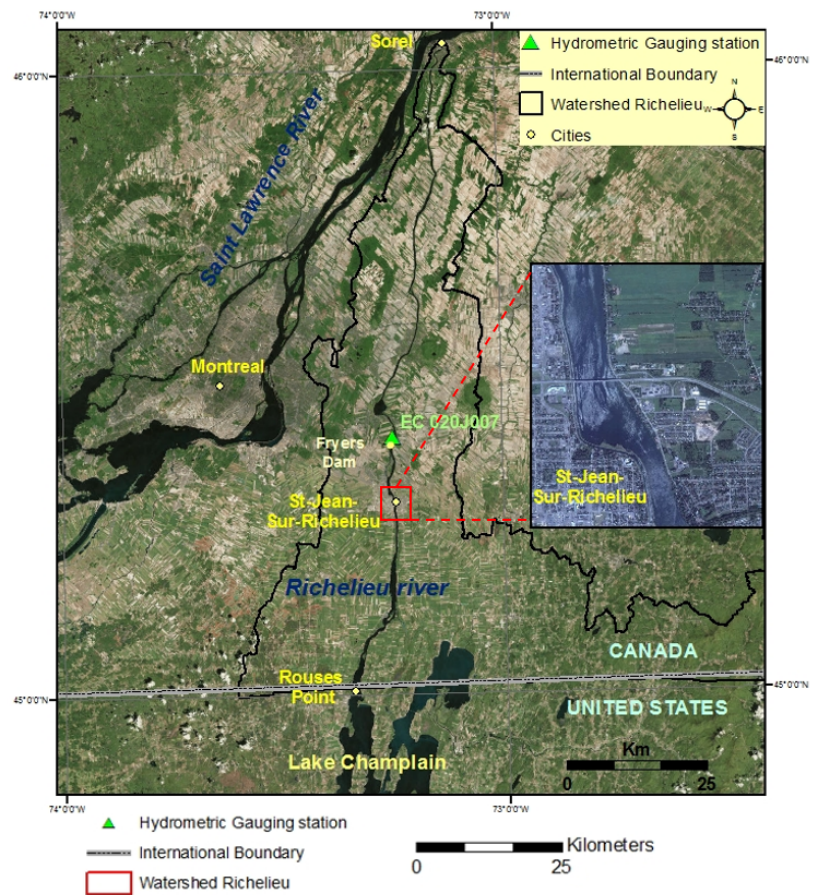
Figure 1. Location of the study area within the Richelieu River watershed together with the shoal at St-Jean-sur-Richelieu.